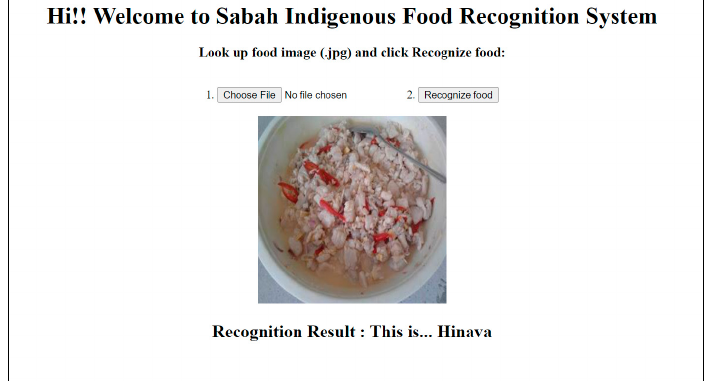
Figure 9. Homepage of the prototype web application.